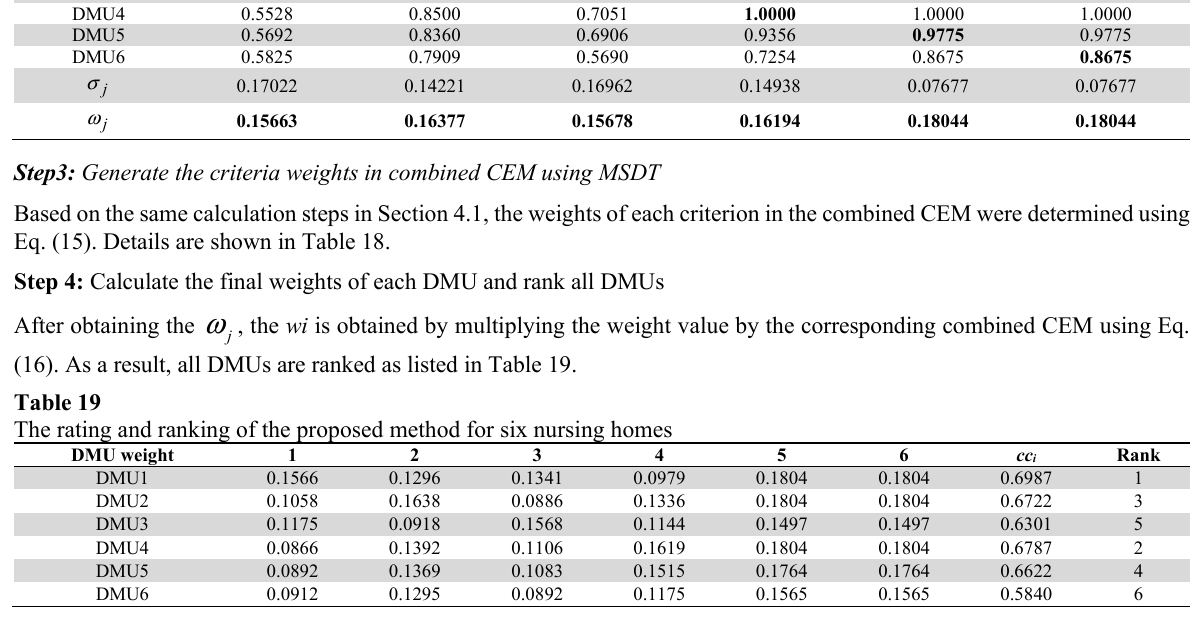
The rating and ranking comparison of the proposed method is shown in Table 20. Finally, Spearman’s rank correlation was used for testing the correlation of each method ( r s ). The details of each r s value are shown in Table 21. The rating and ranking comparison of the proposed method for six nursing homes DMU Benevolent